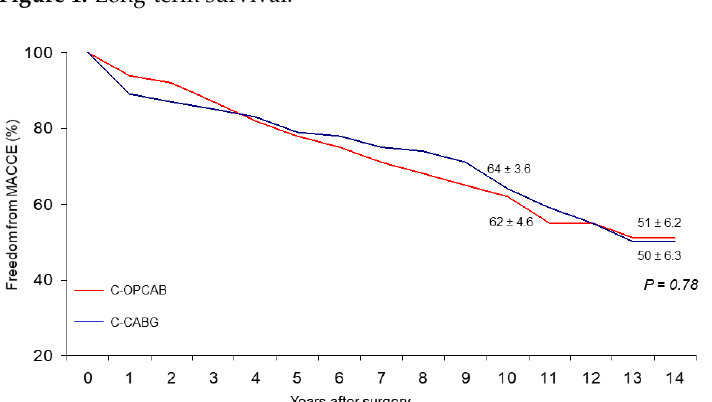
Figure 1. Long-term survival.